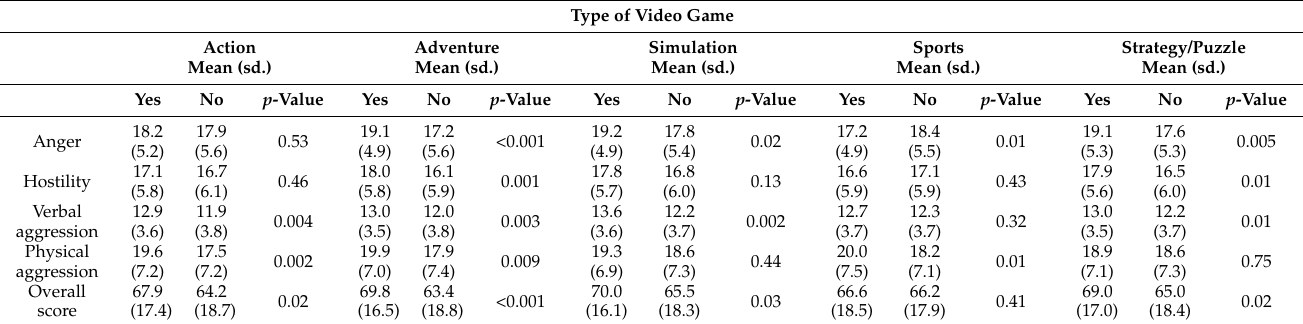
Table 2. Aggression scores of participants playing different types of video games. Type of Video Game